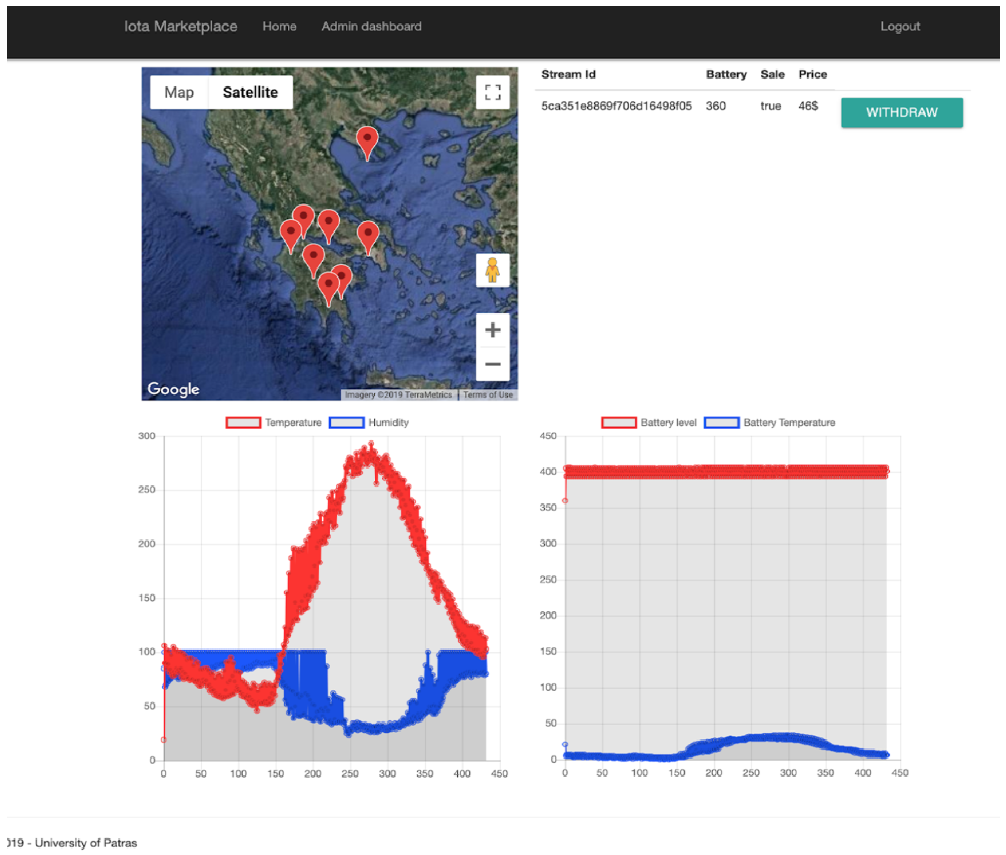
Figure 22. System administrator data